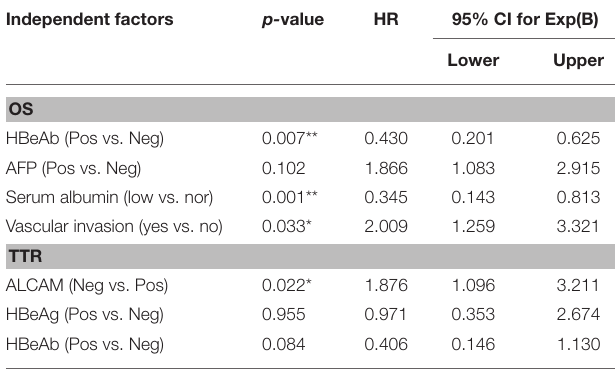
TABLE 2 | Multivariate analysis of factors influencing overall survival (OS) and time to recurrence